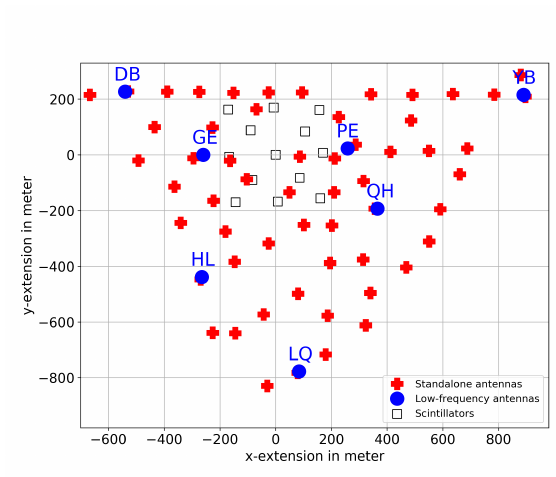
Figure 1: Area experiment at the Nançay Radioastronomy Observatory [7]. Red crosses represent the 57 standalone antennas of CODALEMA, black squares the 13 scintilla- tors, the blue points represent the 7 LF antennas.